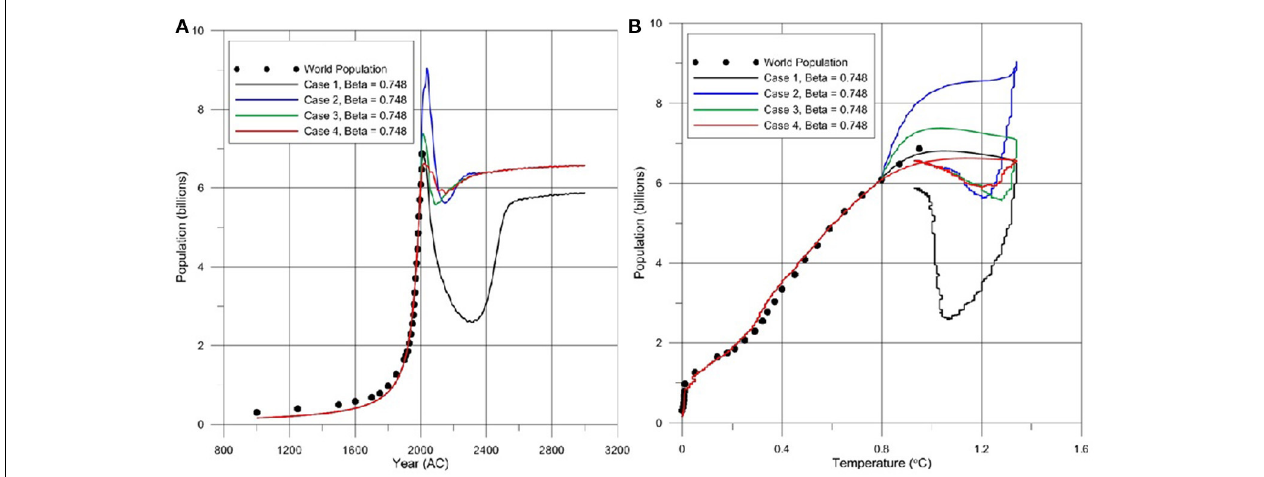
FIGURE 3 | World population stability estimates for 74.8% of the 2%/year peak of CO 2 to level of 450ppmv until year 2050 at P c = 7 billion and persistent global temperatures beyond 2050 as predicted in Solomon et al. (2009): (A) Time series plot; and, (B) Stability phase plane diagram.